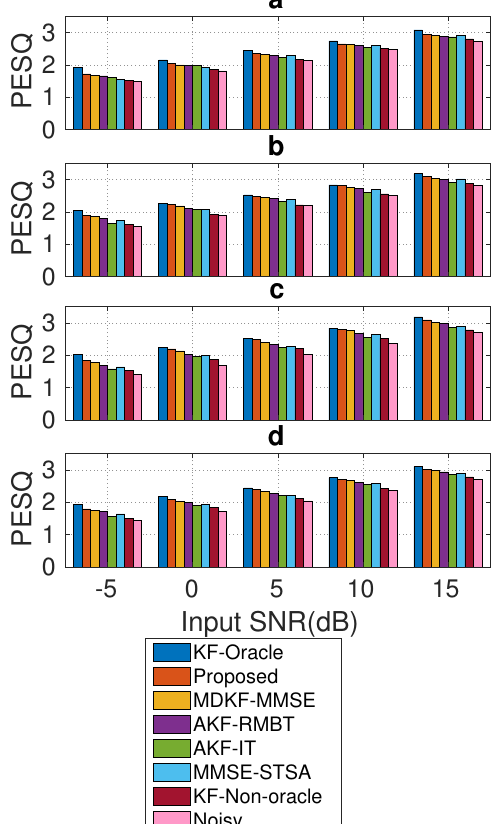
Figure 8. Average PESQ score comparison between the proposed and benchmark SEAs on NOIZEUS corpus corrupted with: ( a ) babble , ( b ) street , ( c ) factory2 , and ( d ) f16 noises for a wide range of SNR levels (from − 5 to 15